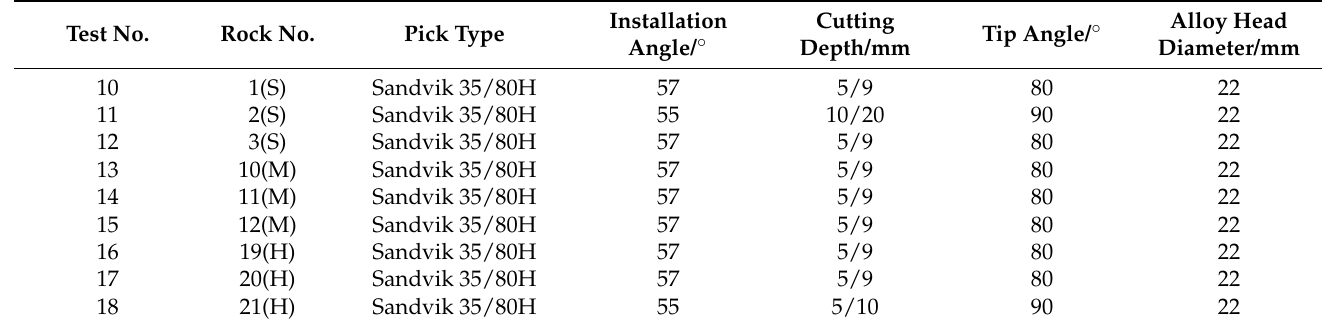
Table 4. The added cutting conditions for the second prediction performance analysis.